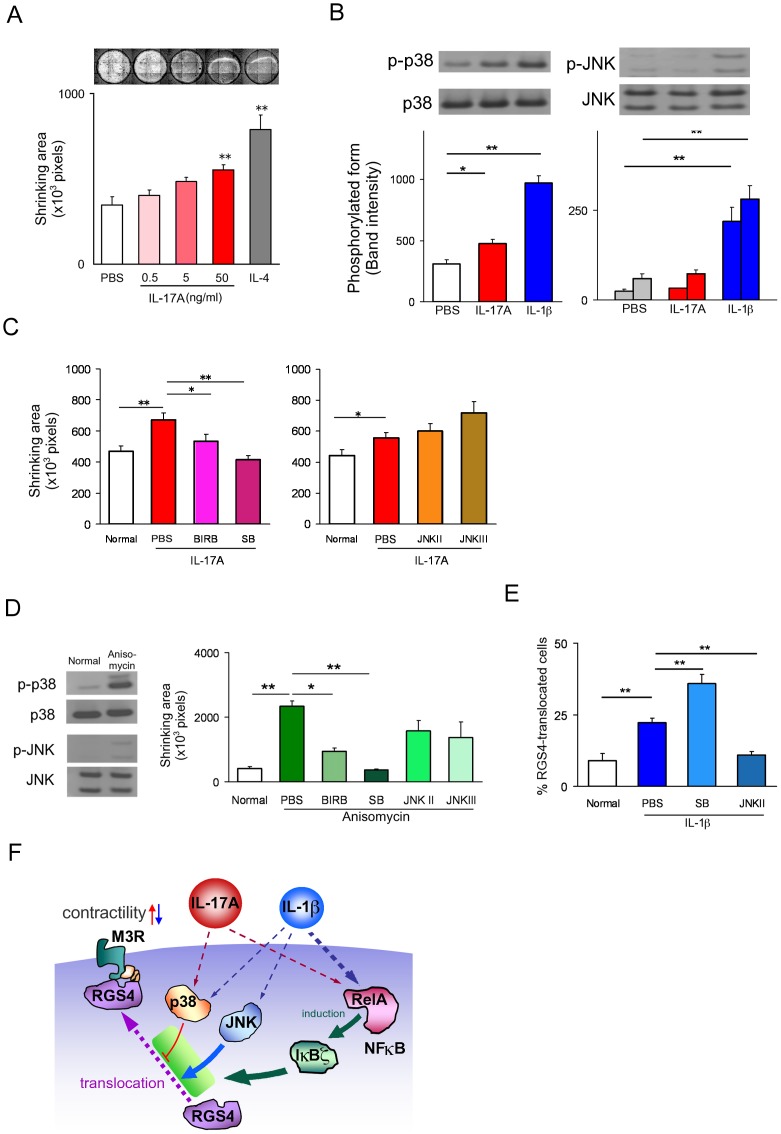
Involvement of p38MAPK activation in IL-17A-mediated hypercontractility in primary cultured murine SI SMCs.(A) Contractility assay of IL-17A-treated SMCs. SMCs were cultured with IL-17A or IL-4 for 4 days using the temperature-responsive cell culture surface, UpCell plates. After addition of 10−11 M CCh, the cell layers became detached from the well during incubation at room temperature. Cell shrinkage was calculated by measuring the area of cell layers (n = 3∼6). Upper panels are representative images. (B) Quantitation of activation of p38MAPK (left panel) and JNK (right panel) by immunoblot analysis. The amount of phosphorylated form of p38MAPK (p-p38) and JNK (p-JNK) was measured (n = 4). (C) Contractility assay of IL-17A-treated SMCs. The effects of p38MAPK inhibitors (left panel) and JNK inhibitors (right panel) are shown. SB203580 (SB, 1 µM), BIRB796 (BIRB, 10 nM), SP600125 (JNK II, 100 nM) and JNK inhibitor III (JNK III, 100 nM) were added 15 min before addition of IL-17A (50 ng/ml). Contractility was measured as described in Fig. 6A (n = 8). (D) Effect of MAPK inhibitors on on anisomycin-induced contractility. The activation of p38MAPK by anisomycin was demonstrated by the representative images of the immunoblot in the left panel. The right panel shows the effects of p38MAPK and JNK inhibitors on anisomycin-induced contractility. Contractility was measured the day after addition of anisomycin (n = 4). (E) The effects of p38MAPK and JNK inhibitors on IL-1β-induced RGS4 translocation. RGS4 activity was evaluated by Celaview analysis as described in Fig. 5D (n = 4). Numerical data represent means ± s.e.m. *P<0.05, **P<0.01, Student's t-test under the closed testing procedure for multiple comparison (A–E). (F) Scheme of IL-17A and IL-1β signalling leading to hyper- and hypo-contractility induced by IL-17A and IL-1β, respectively. IL-17A induces p38 MAPK phosphorylation and NFκB activation (i.e., translocation of p65 RelA protein into the nucleus) independently within 15 min. Inhibition of p38 MAPK activation had no effect on RelA translocation and conversely, inhibition of NFκB activation had no effect on MAPK phosphorylation (data not shown). The expression of IκBζ, which is virtually absent without NFκB activation was massively induced after 30 min. The decrease in translocation of RGS4 protein to the cell membrane, where RGS4 suppresses muscarinic receptor-mediated signalling via interaction with G proteins coupled to muscarinic receptor, was observed between day 1 and day 4. A significant hypercontractility of SMCs began to be detected after day 2 and continued through to day 4. Inhibition of p38MAPK and NFκB/IκBζ activation both suppressed IL-17-induced hypercontractility and the changes of RGS4 translocation. By contrast, IL-1β activates JNK as well as NFκB/IκBζ and p38MAPK. Inhibition of NFκB/IκBζ and JNK abrogated the effect of IL-1β while p38MAPK inhibition enhanced it. Thus the balance in the relative activity levels of JNK and p38MAPK is critical for determining the direction of contractility. NFκB-IκBζ signalling regulates the movement of MAPK-triggered molecular events toward/against hypercontractility of SI SMC.